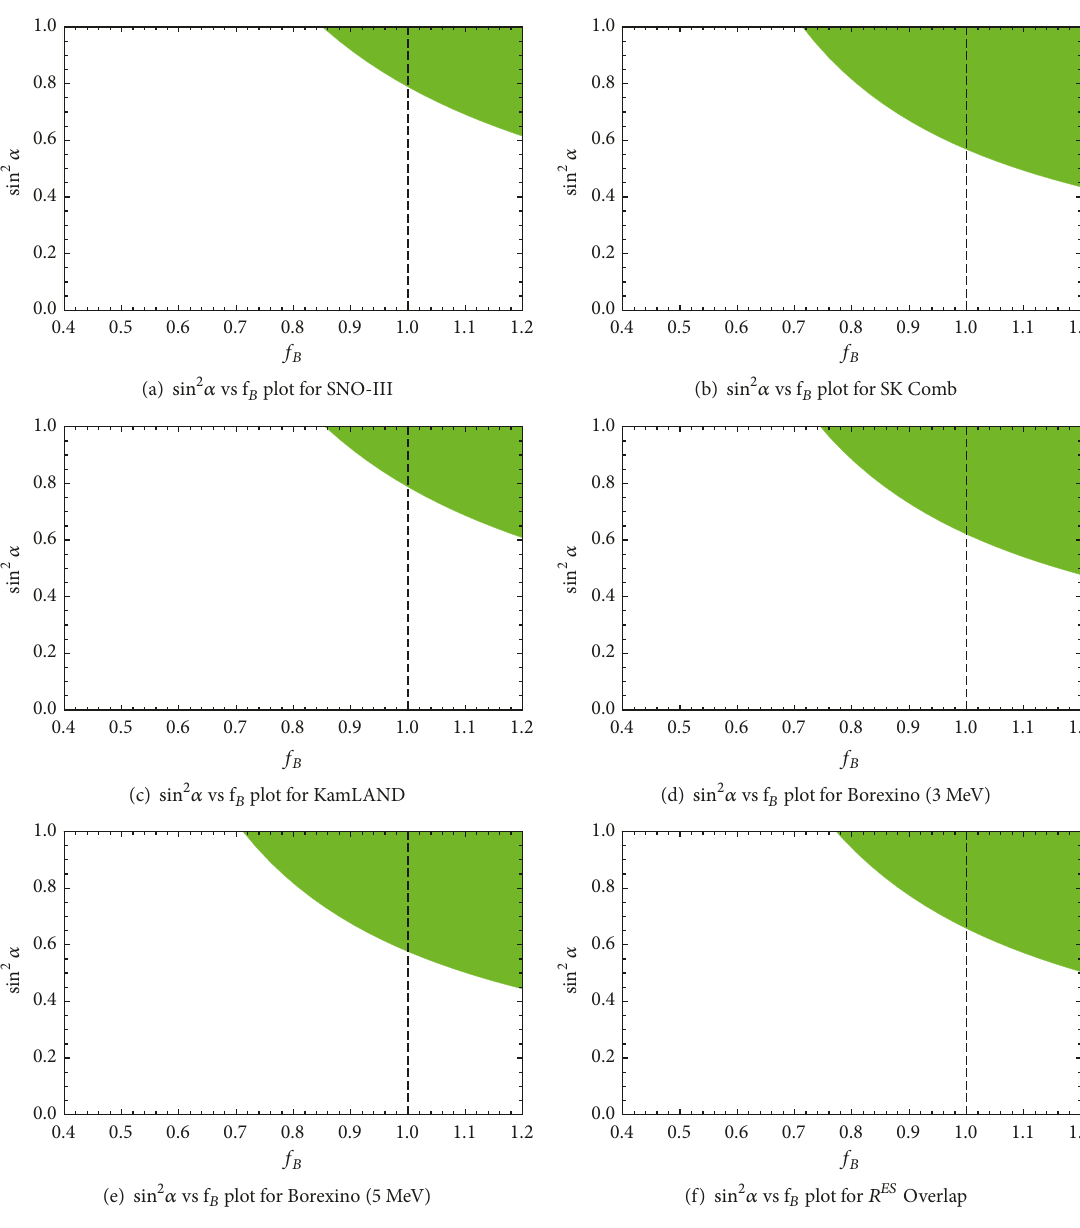
(b) sin 2 𝛼 vs f 𝐵 plot for SK Comb